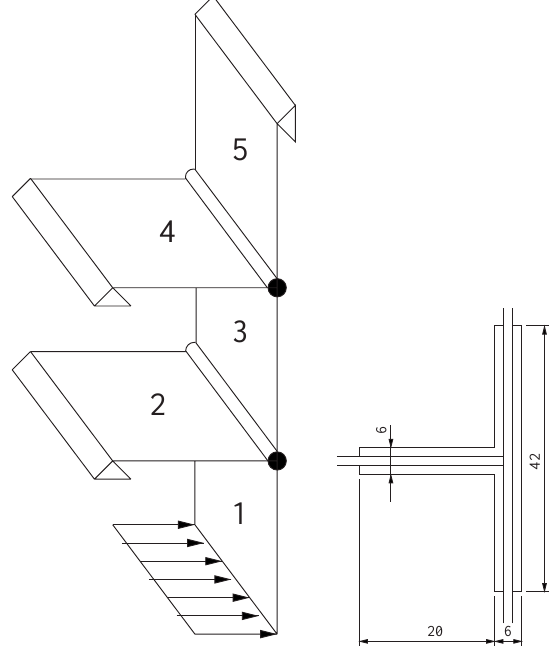
Fig. 8. The two-dimensional structure under analysis with a zoom on the junction.